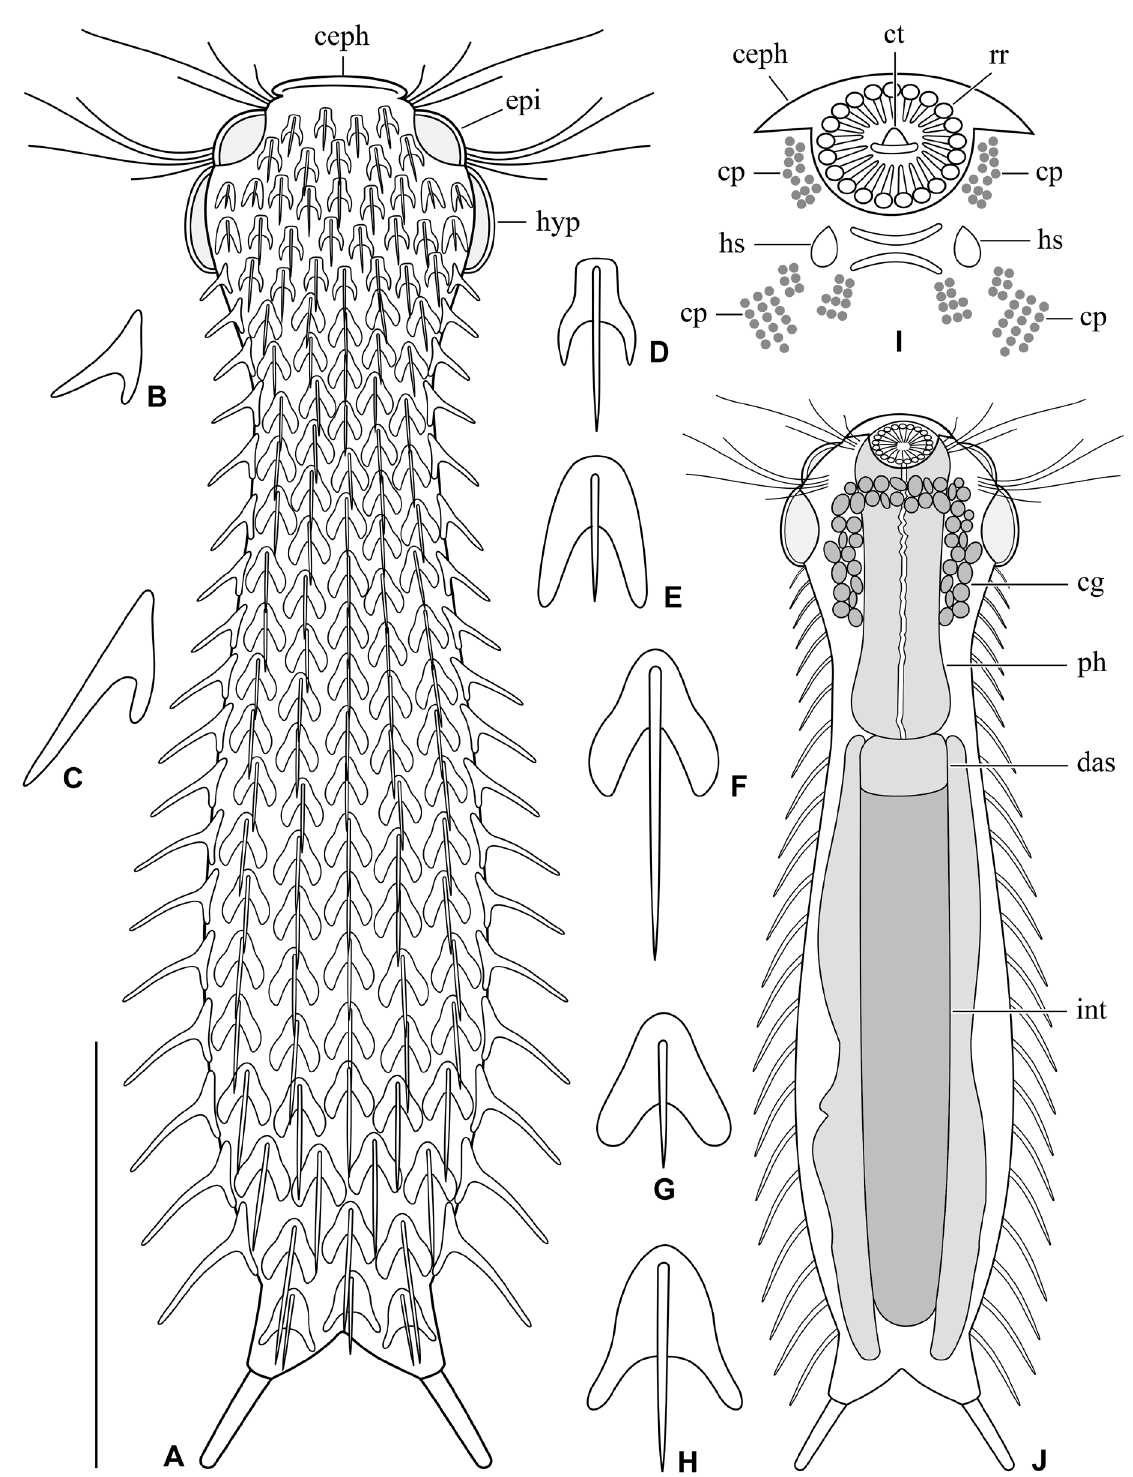
Fig. 31. Chaetonotus ( Hystricochaetonotus ) iratus sp. nov. A . Dorsal overview showing the scale and spine pattern. B , D . Lateral and dorsal views of a head scale. C , F . Lateral and dorsal views of a trunk scale. E . Dorsolateral head scale. G . Ventrolateral trunk scale. H . Furca branches scale. I . Detail showing the mouth region. J . Internal morphology. The structure of the cerebral ganglion was observed only in a single specimen. Scale bar = 30